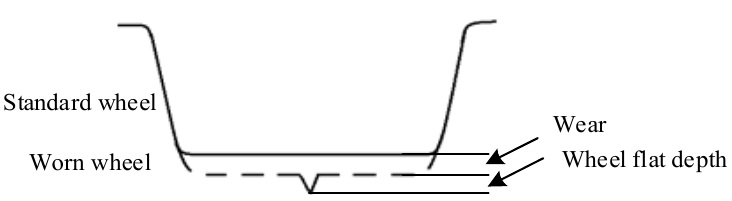
Figure 3. An output waveform of the measuring device under ideal conditions.